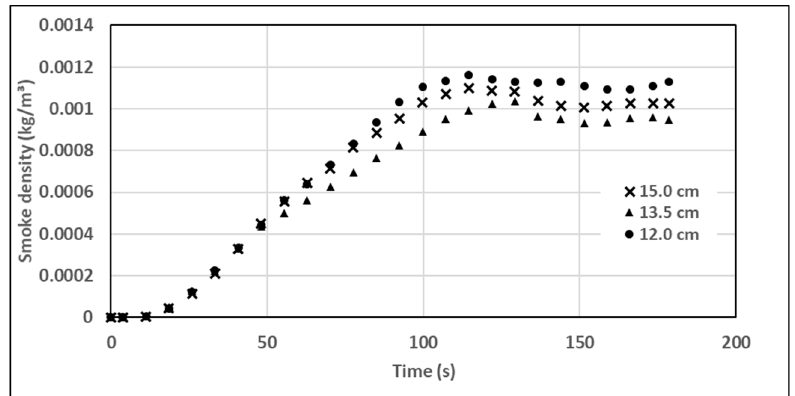
Figure 3. Mesh independence results.